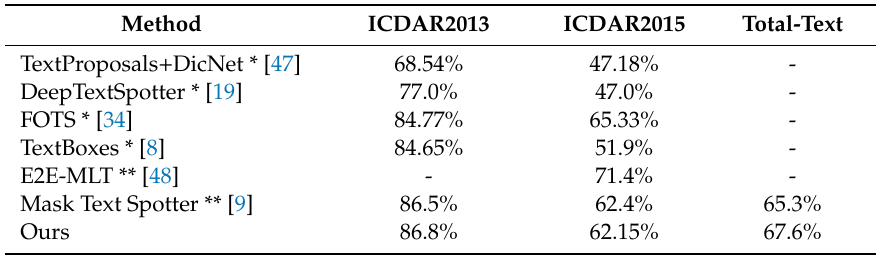
Table 3. F1-Score experimental results of the proposed unconstrained scene text reading system compared with previous methods.